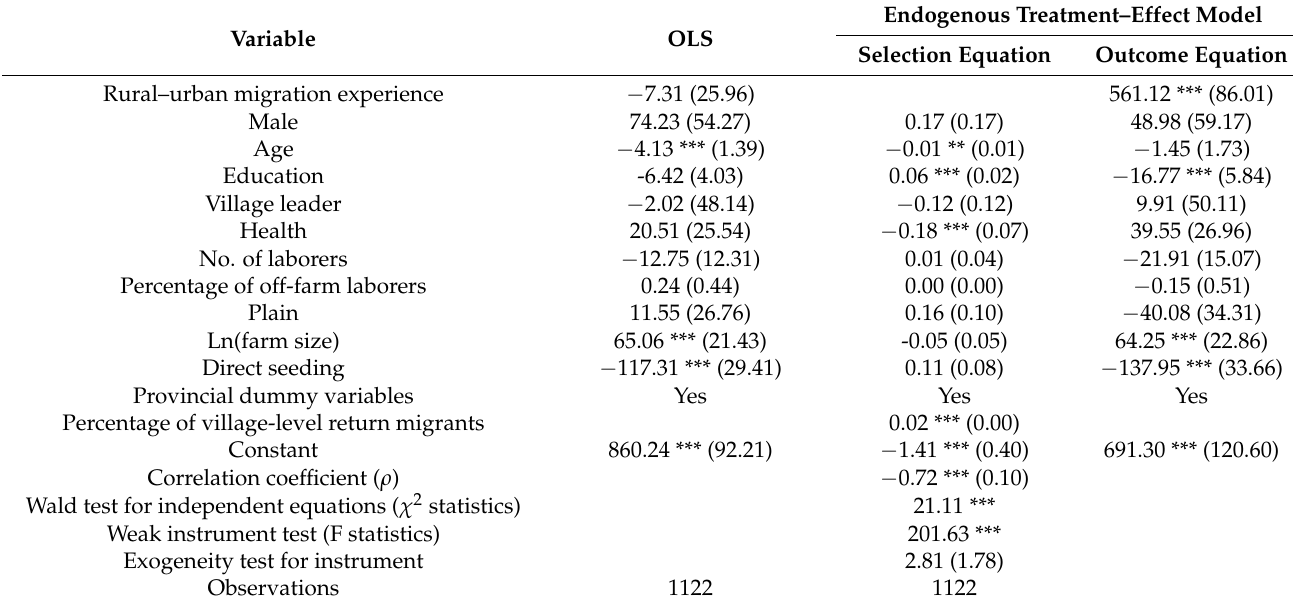
Table 2. The impact of rural–urban migration experience on agricultural